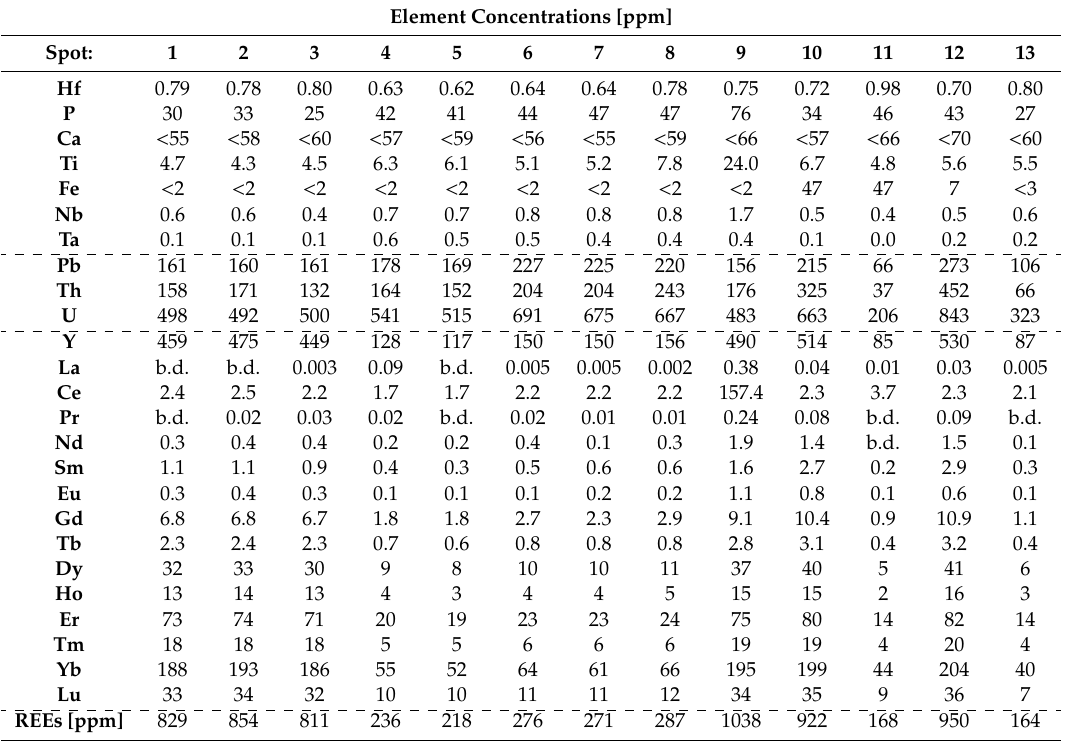
Table A9. Trace-element concentrations from multiple spot measurements on zircon sample SL2 from the Ratnapura district, Sri Lanka, as obtained by LA-ICP-MS. Concentrations given in ppm, except for Hf that are given in wt.-%. Totals of REEs comprise Y + La to Lu. Note, that measurement spots for trace-elements di ff er from those chosen for U-Pb isotopic dating (Table A4, Figure